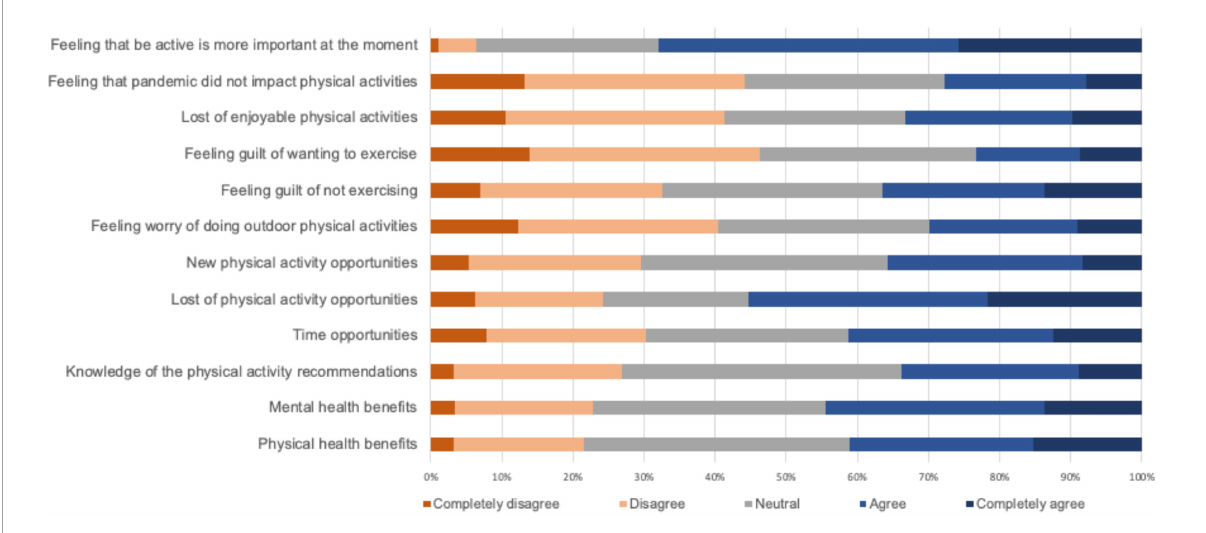
FIGURE1 Participants attitudes and feelings about physical activity (PA) and